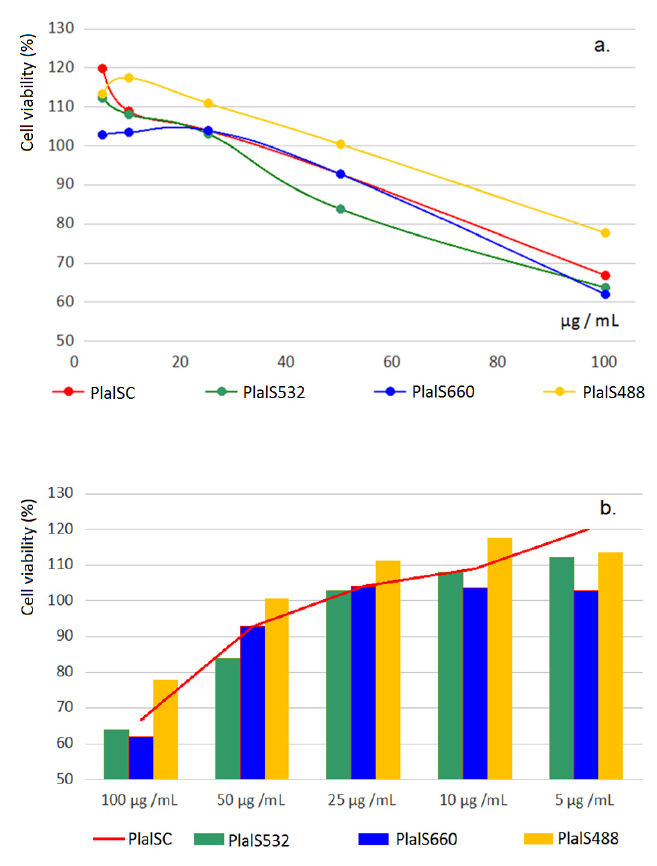
Figure 6. ( a , b ) Caco-2 cell viability at 24 h., non-irradiated control extracts (PlalSC) versus laser- assisted extracts at 488 nm (PlalS488), 532 nm (PlaSl532), and 660 nm (PlaSl660). Table 4. IC 50